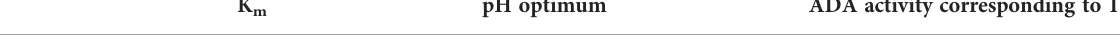
TABLE 1 Catalytic parameters of recombinant human ADA2 and